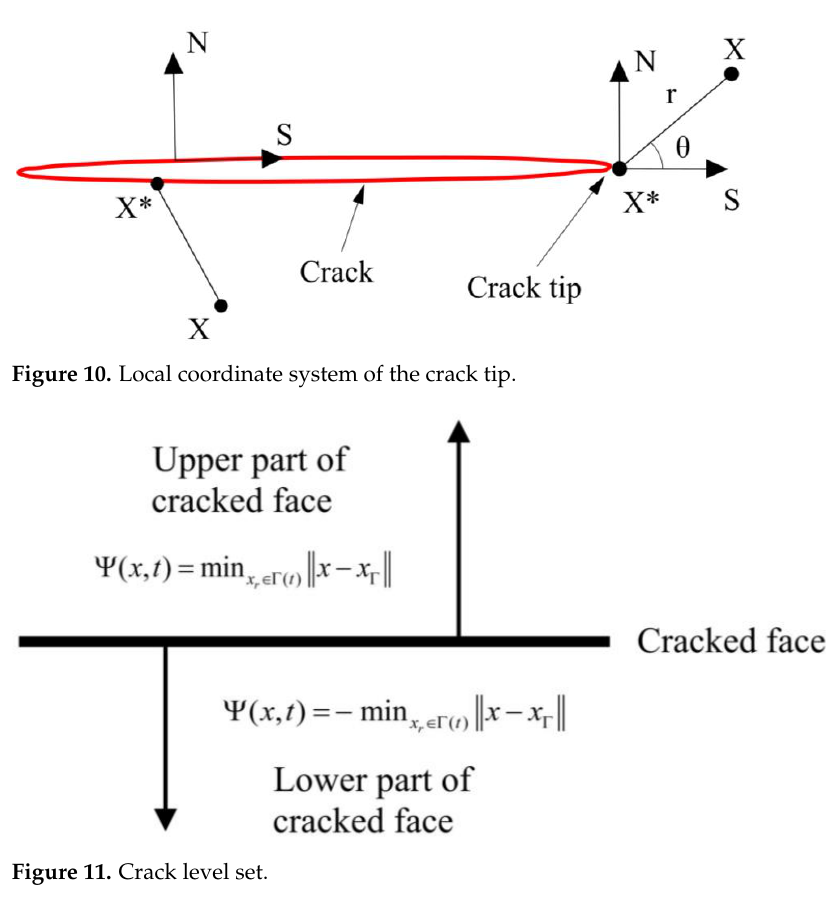
Figure 11. Crack level set.